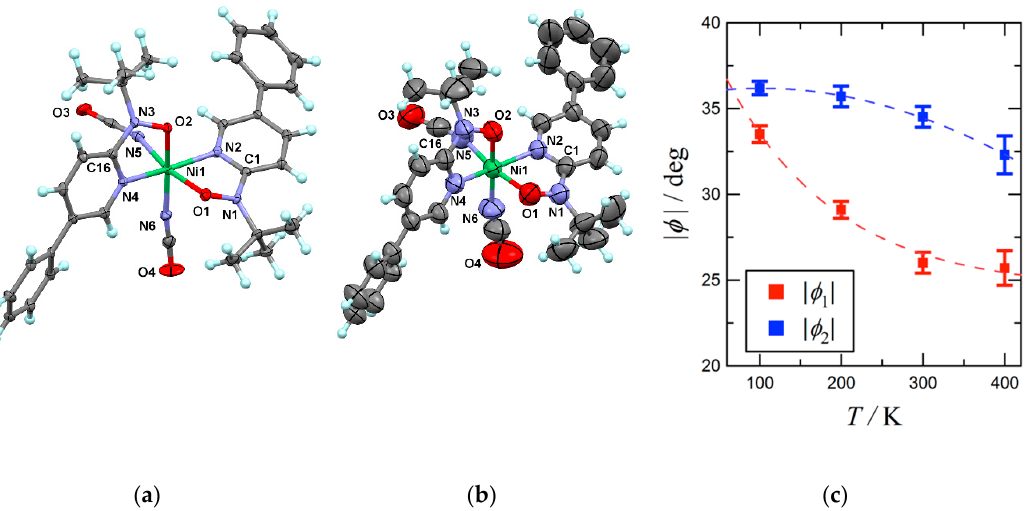
Figure 1. ( a ) X-ray crystal structure of 4 measured at 100 K and ( b ) 400 K. Thermal ellipsoids are drawn at the 50% probability level. Selected atomic numbering is also shown. ( c ) Temperature dependences of torsion angles ( | ϕ | ) for 4 . Broken lines are drawn for a guide to the